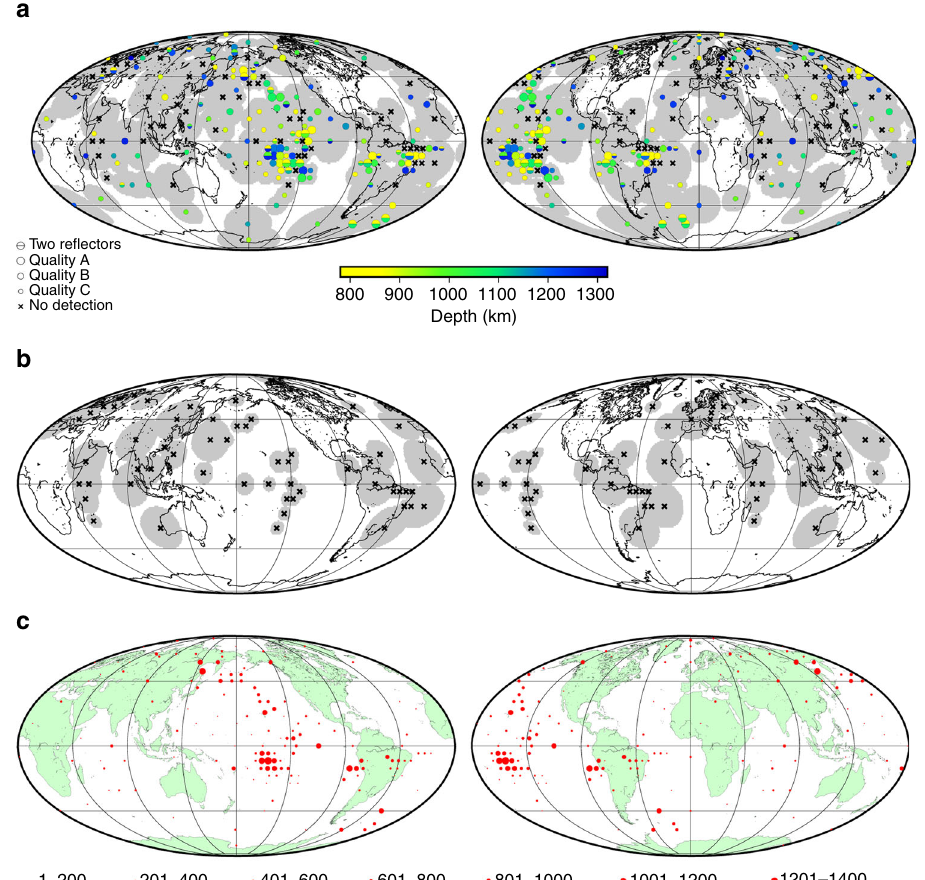
Fig. 5 Data coverage and distribution of bounce points with respect to bins. a Data coverage of all bins. Shaded regions correspond to regions included in bins. Non-shaded areas are regions with insuf fi cient data coverage or poor-quality stacks that were removed after quality checking. b Data coverage for only bins with non-detections. c Data distribution per bin. The size of circles in each bin shows the number of data in each bin (see legend). Corresponding maps for all bins sizes are in the Supplementary Material, along with maps showing the regions without data coverage superimposed on the combined